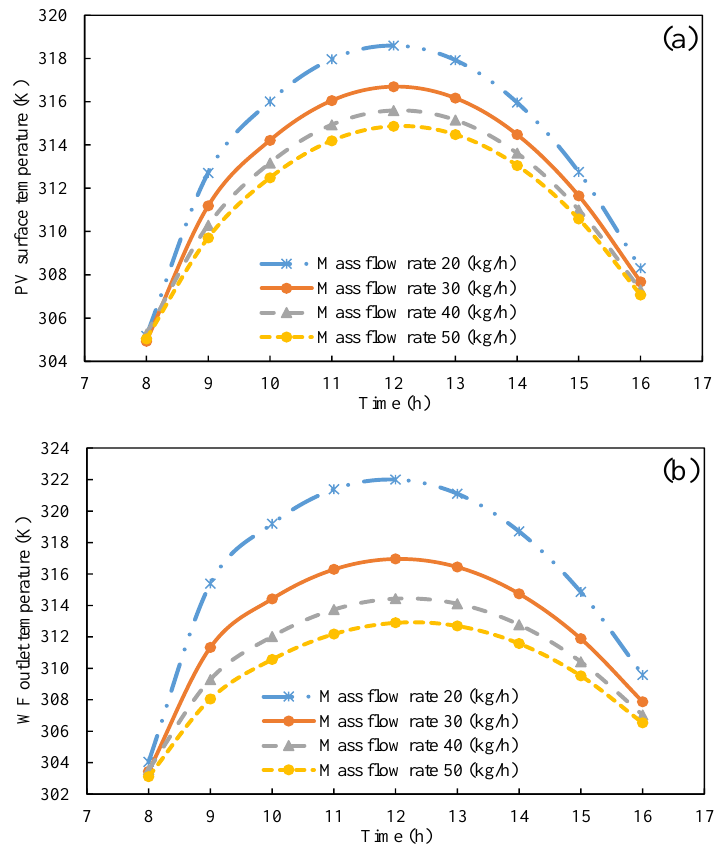
Fig. 6. Temporal variations of the (a) PV surface temperature and (b) WF outlet temperature at different mass flow rates during a day in